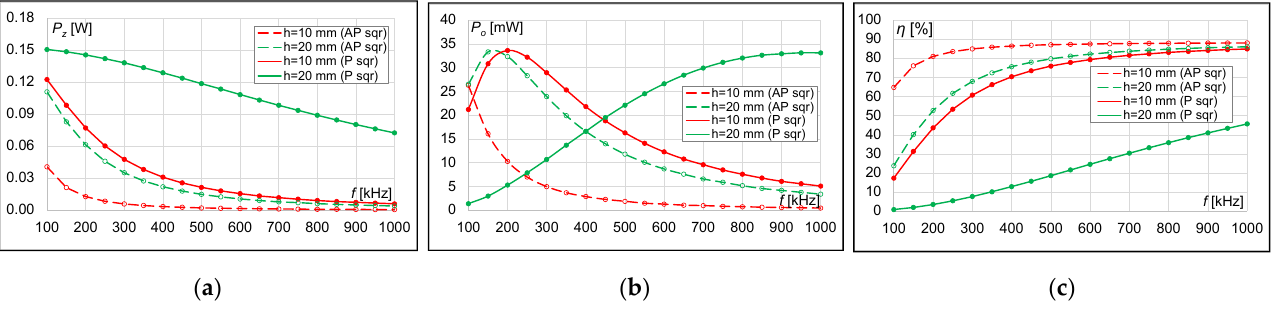
Figure 16. Results for square coils with r = 20 mm and the number of turns n = 50 at two distances ( h = 10 mm and h = 20 mm): ( a ) transmitter power, ( b ) receiver power, ( c ) power transfer efficiency.